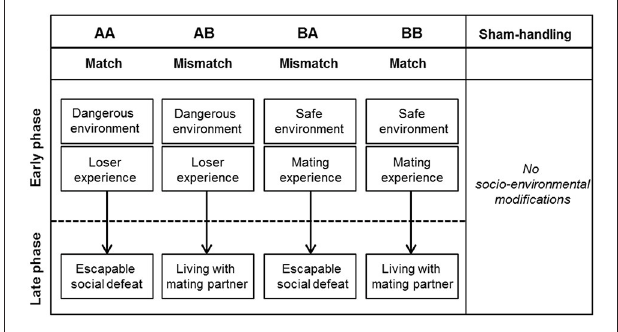
FIGURE 1 | Overview of the four different life histories and sham-handled mice. The figure shows the five different experimental groups of male C57BL/6J mice, subdivided into four different life histories (AA, AB, BA, and BB) and a sham-handled group (SH). Every life history comprises an early and a late phase, each being either adverse or beneficial. Sham-handled mice received no modifications in their social environment ( n = 138) (figure modified after Bodden et al.,